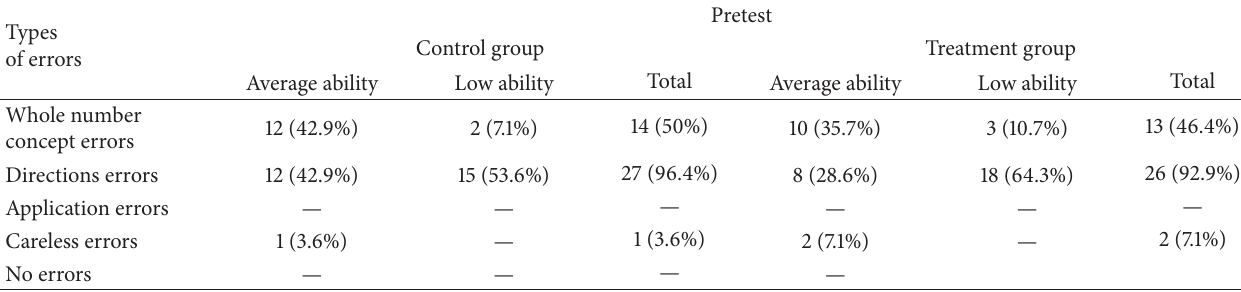
Table 5: Distribution of errors in the subtraction of fractions made by the control group and treatment group in the pretest.